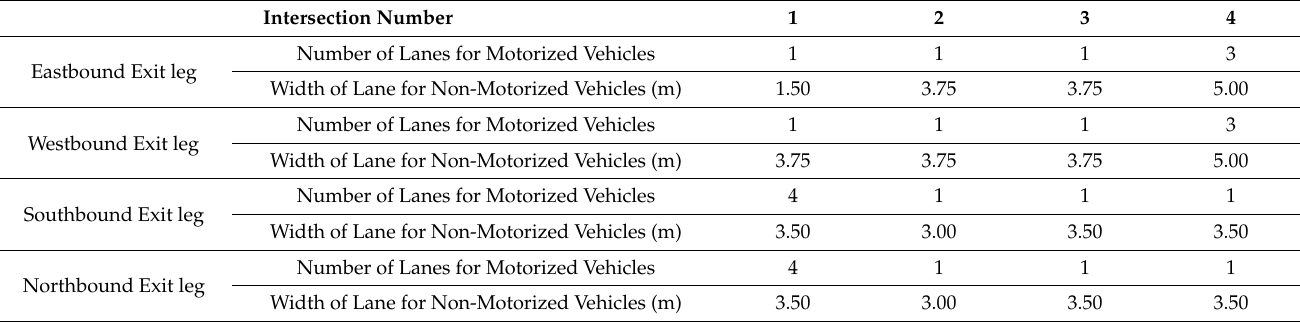
Table 1. Characteristics of exit legs of the four selected